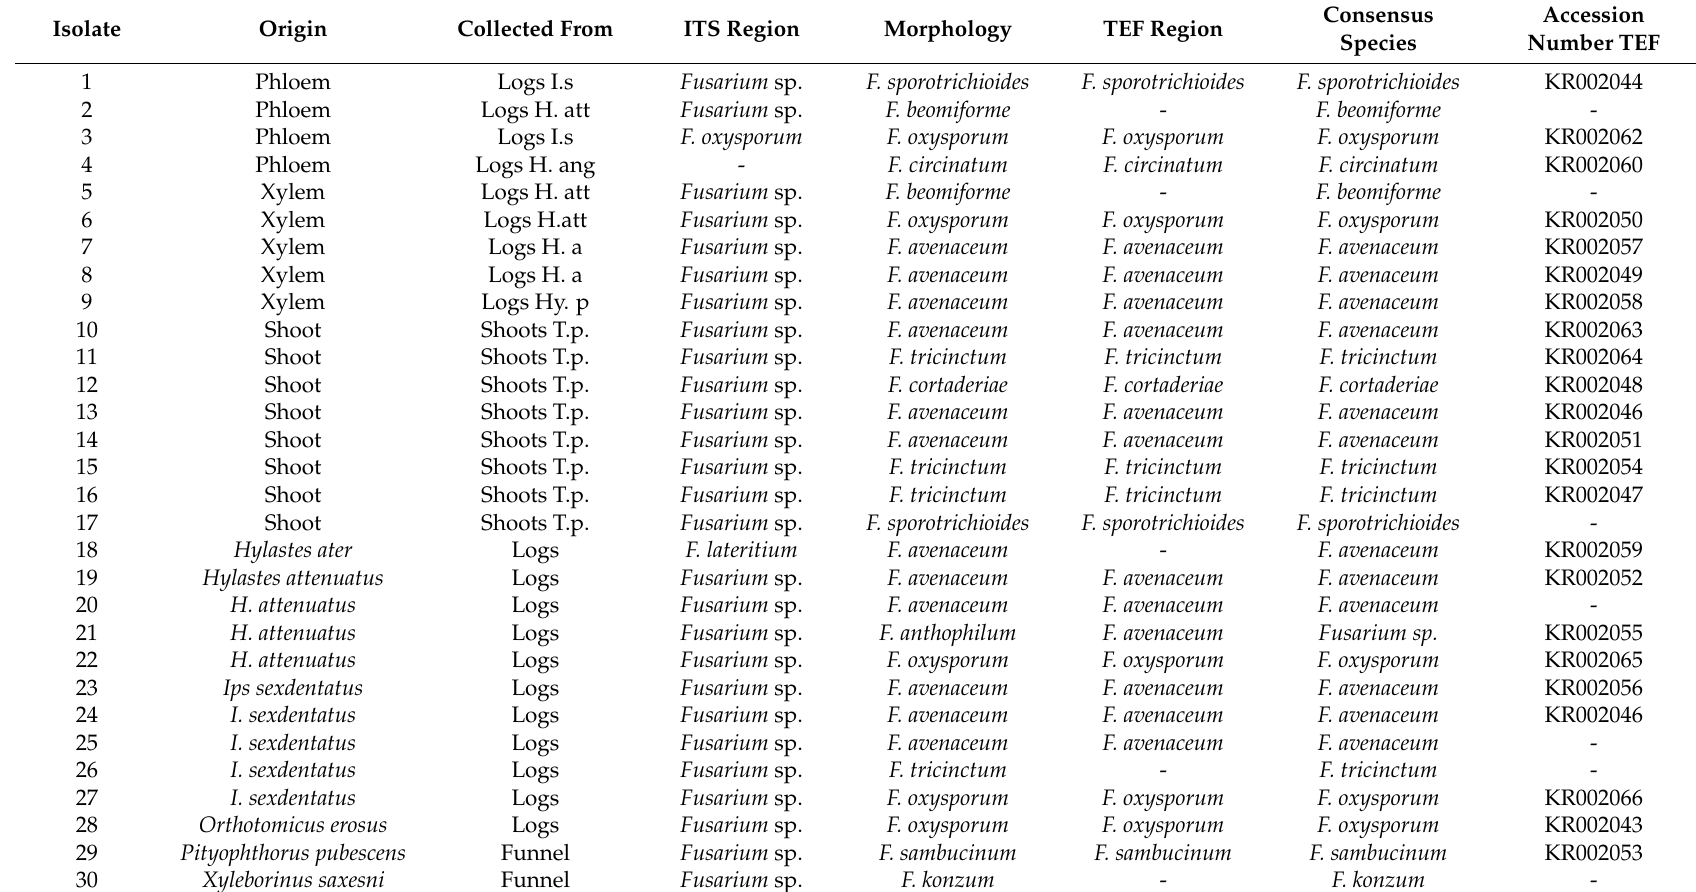
Table 4. Isolates of Fusarium species identified by different